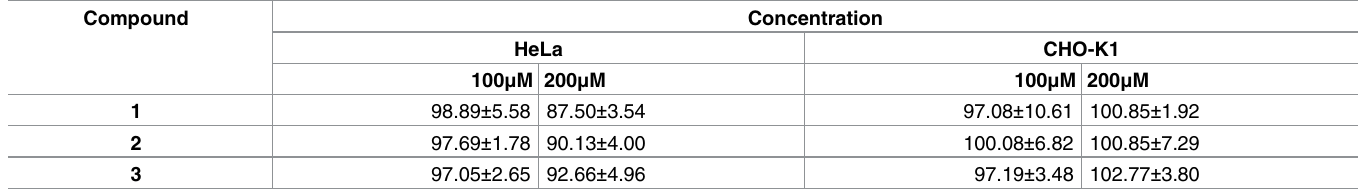
Table 3. Effect of halolactones (1, 2, 3) on HeLa and CHO cell viability, determined by the WST-I assay. The viability(%) was expressedas percentage of treated cells versus control cells.